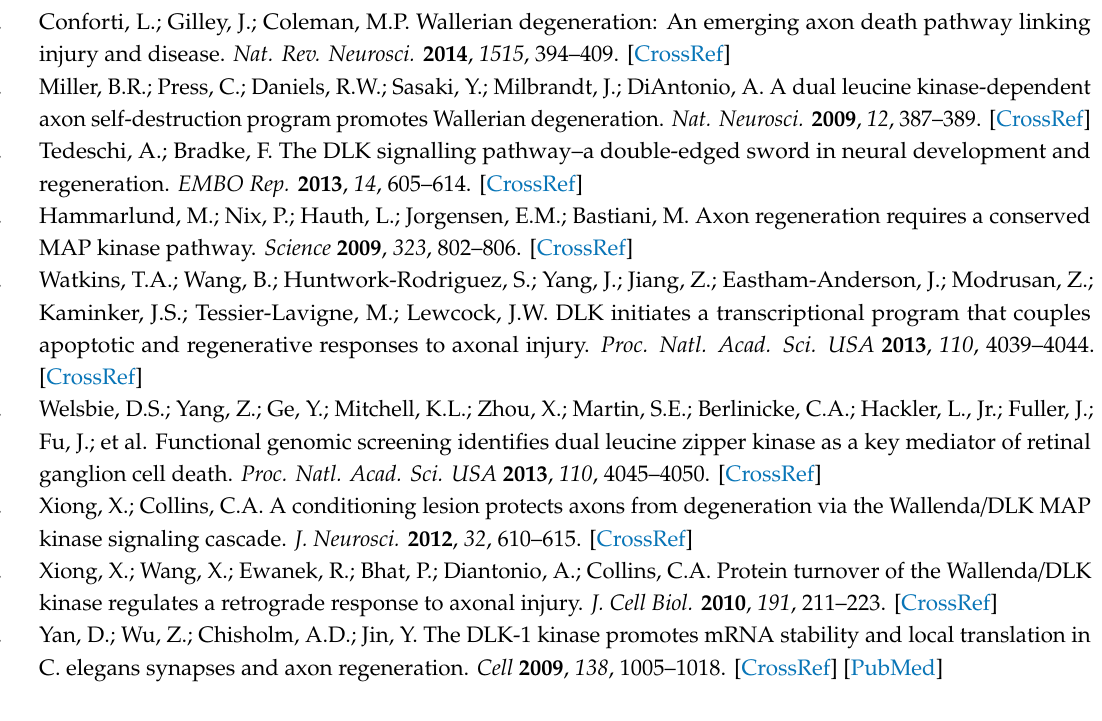
Figure S4. Pharmacological inhibition of DLK inhibits constitutive as well as induced p-c-Jun in adult mouse brain. ( a ) The pharmacokinetic / pharmacodynamic relationship between total plasma DLKi exposure and % p-c-Jun / GAPDH reduction and total brain DLKi exposure and % p-c-Jun / GAPDH reduction measured in Figure 3a–c. The in vivo IC 50 obtained from total plasma DLKi exposure and total brain DLKi exposure was 1.57 µ M and 2.59 µ M, respectively. ( b ) The pharmacokinetic / pharmacodynamic relationship between free plasma DLKi exposure and % p-c-Jun / GAPDH reduction and free brain DLKi exposure and % p-c-Jun / GAPDH reduction measured in Figure 3a–c. The in vivo IC 50 obtained from free log plasma DLKi exposure and free log brain DLKi exposure was 0.207 µ M and 0.176 µ M, respectively. Concentration of DLKi plotted as logarithmic scale on the X-axis, Figure S5. Selectivity of DLKi in mouse brain. ( a ) Graphical representation of the kinases examined for kinome selectivity in 3–4 months old male WT mice dosed with single oral dose of DLKi by ActivX KiNativ analysis. ( b ) Percent DLK binding in 3–4 months old male WT mice brain tissue assessed by ActivX KiNativ assay plotted against the dose of DLKi (5 mg / kg ( n = 2), 15 mg / kg ( n = 2), and 50 mg / kg ( n = 2)). ( c ) Percent DLK binding in 3–4 months old WT mice brain tissue assessed by ActivX KiNativ assay plotted against the total brain concentration of DLKi and free brain concentration of DLKi. Concentration of DLKi plotted as logarithmic scale on X-axis, Figure S6. Pharmacokinetic analysis of DLKi in brain at di ff erent time-points. ( a ) Schematic representation of study timeline; 3–4 months old male WT mice ( n = 5) were dosed with single oral dose of 50 mg / kg of DLKi or vehicle. The study was terminated approximately 2, 4, 8, 12, or 24 h after single dose. ( b ) Plot of total brain concentration of DLKi and free brain concentration of DLKi against time (h) from mice dosed with single dose of DLKi. Dotted line represents IC50 of the DLKi, Figure S7. Di ff erentially expressed genes in the MAPK pathway ( > 2-fold change) in nTg cerebellum versus nTg forebrain (padj <